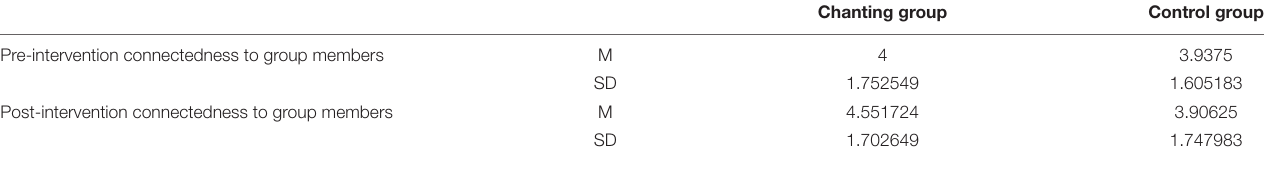
TABLE A3 | Social connectedness to members in